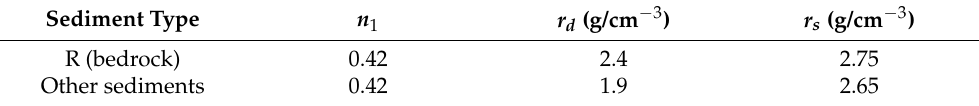
Table 2. Values for thaw settlement coefficient